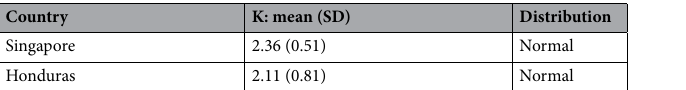
Table 11. The beta estimates by country. All estimates are obtained from literature search.